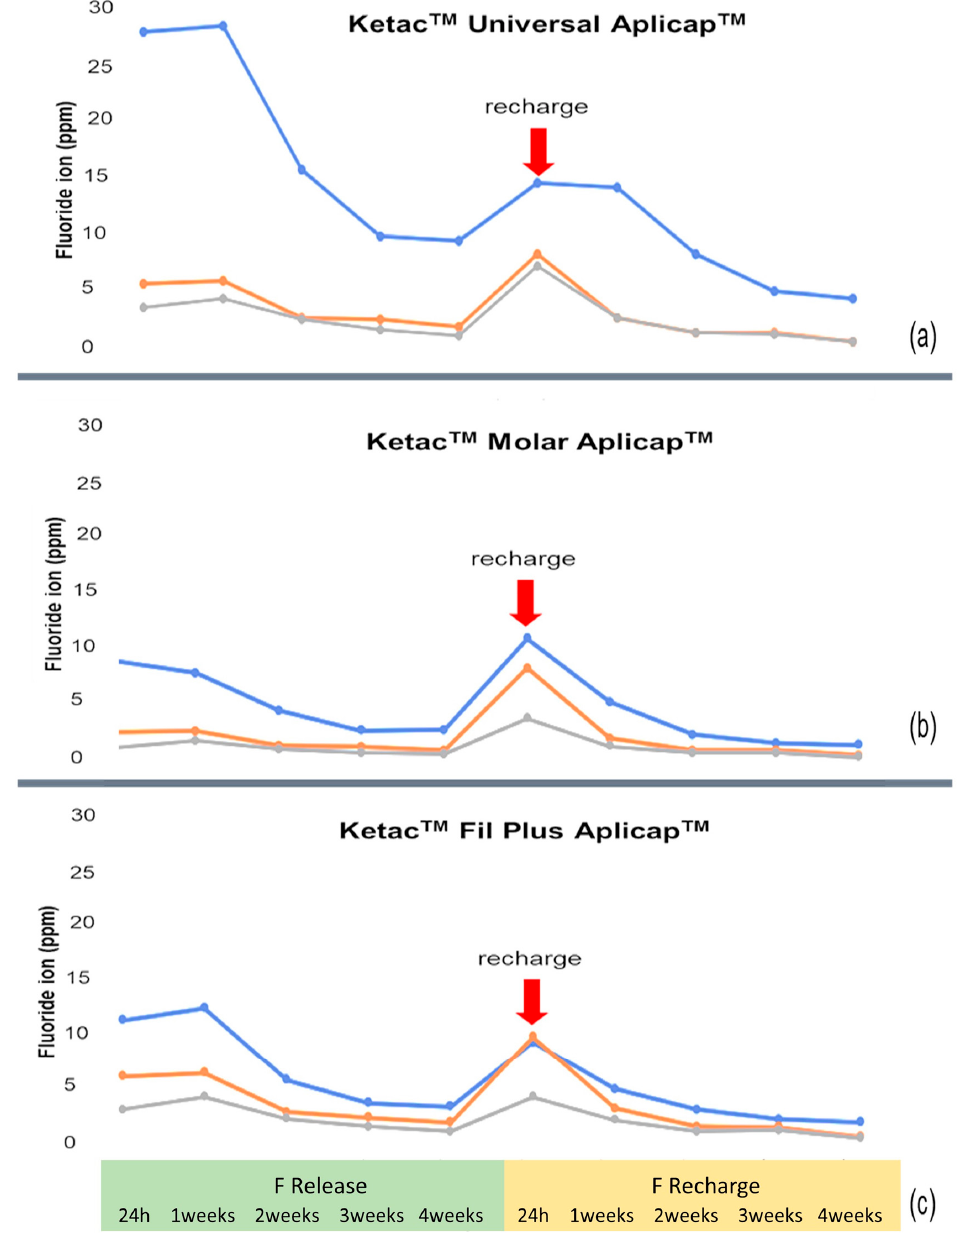
Figure 4. Means of the amount of fluoride (ppm) for each surface coating procedure and each type of material: ( a ) Ketac TM Universal Aplicap TM , ( b ) Ketac TM Molar Aplicap TM , and ( c ) Ketac TM Fil Plus Aplicap TM at 24 h and at 1, 2, 3, and 4 weeks of fluoride release and recharge. The recharge point was before the fluoride release measurement, and the fluoride recharge measurement was after exposure to a 1.23% APF gel.